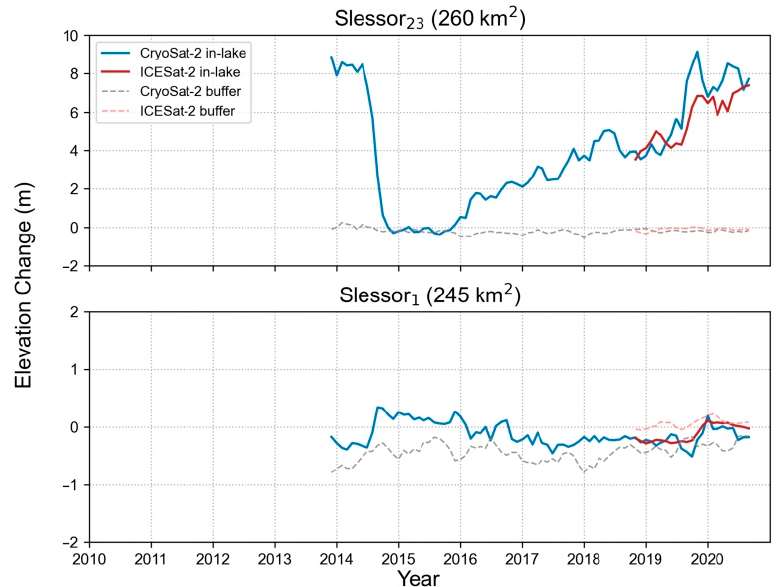
Figure 6. Time series of the ice surface elevation changes of the subglacial lakes beneath the Slessor Glacier. The subplots are arranged from upstream to downstream.